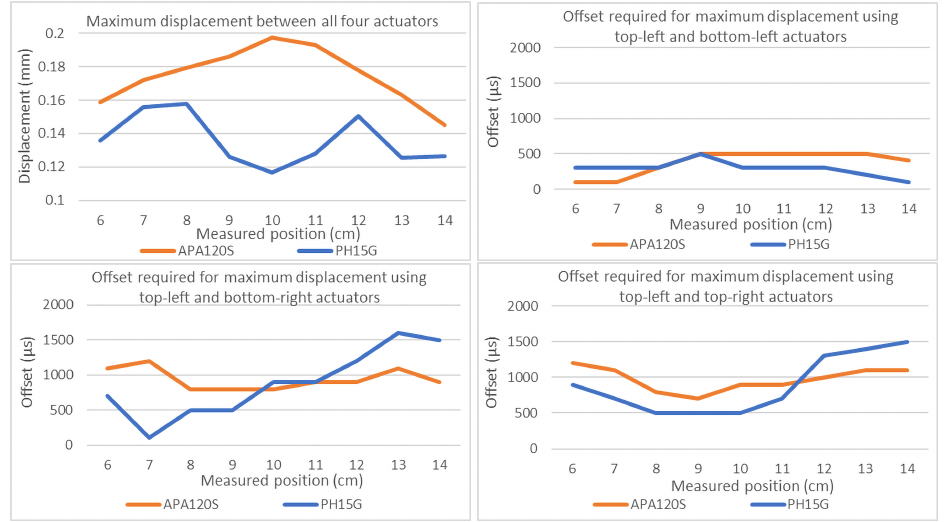
Figure 8. Required offsets for actuator pairs to achieve maximum displacement at given points across the control panel